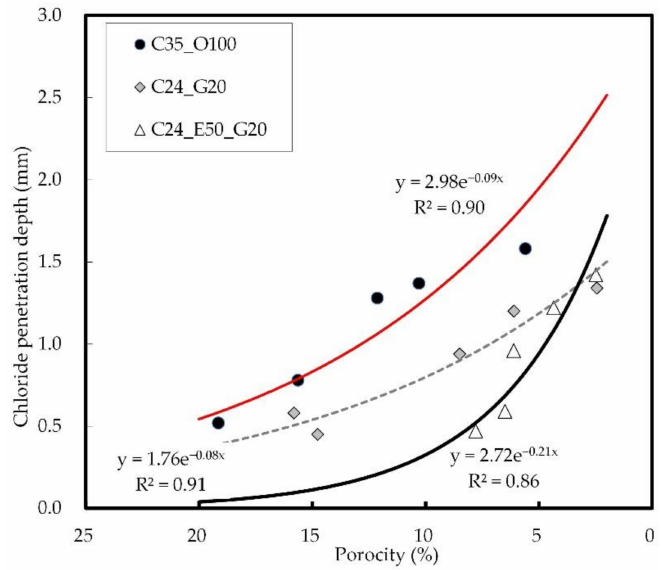
Figure 15. Relation between internal porosity and chloride penetration depth on concrete.